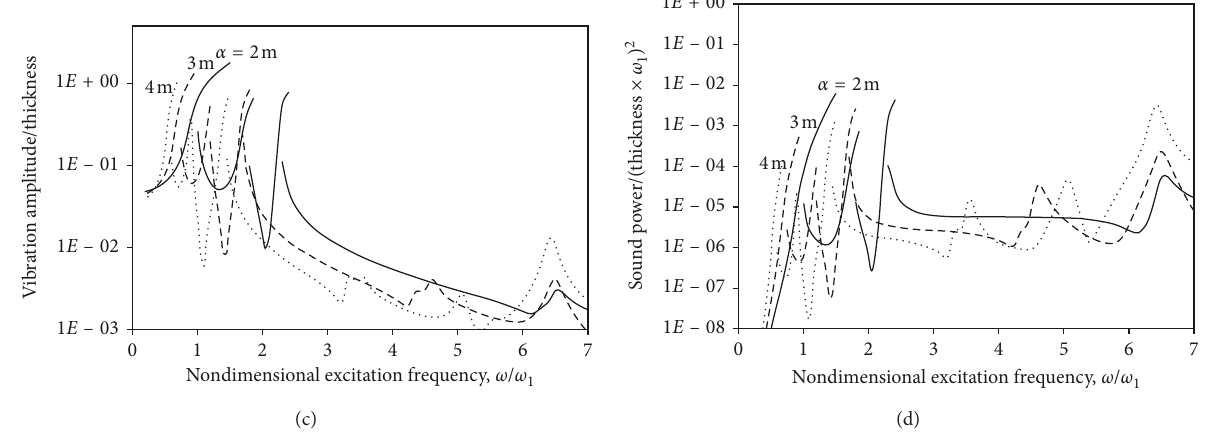
Figure 5: (a) Symmetric and (c) antisymmetric vibration amplitude versus excitation frequency for various panel lengths ( κ b c 0.5m, ξ 0.02, and N 4); (b) symmetric and (d) antisymmetric sound radiation versus excitation frequency for various panel lengths (cid:31) (cid:31) (cid:31) (cid:31) ( κ 0.2, b c 0.5 m, ξ 0.02, and N 4). (cid:31) (cid:31) (cid:31) (cid:31) (cid:31)